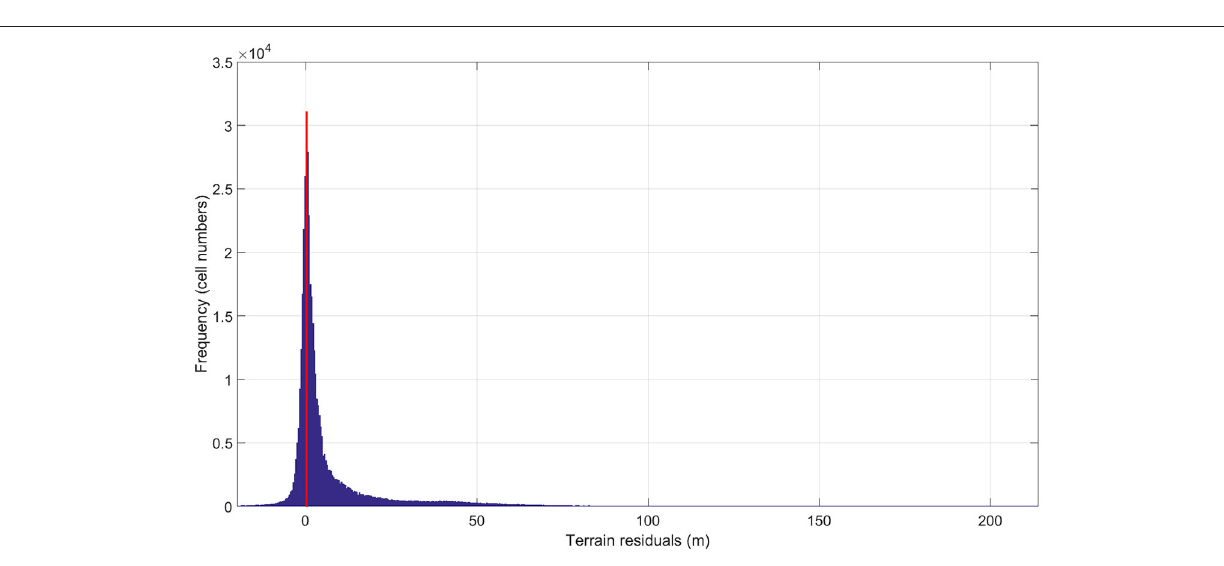
TADR of 1.53 ± 0.31 m 3 s − 1 ; (iii) a peak phase, from 19 February 2013 to 27 April 2013, with a TADR of 3.68 ± 0.74 m 3 s − 1 ; (iv) a waning phase, from 26 October 2013 to 7 July 2014, with